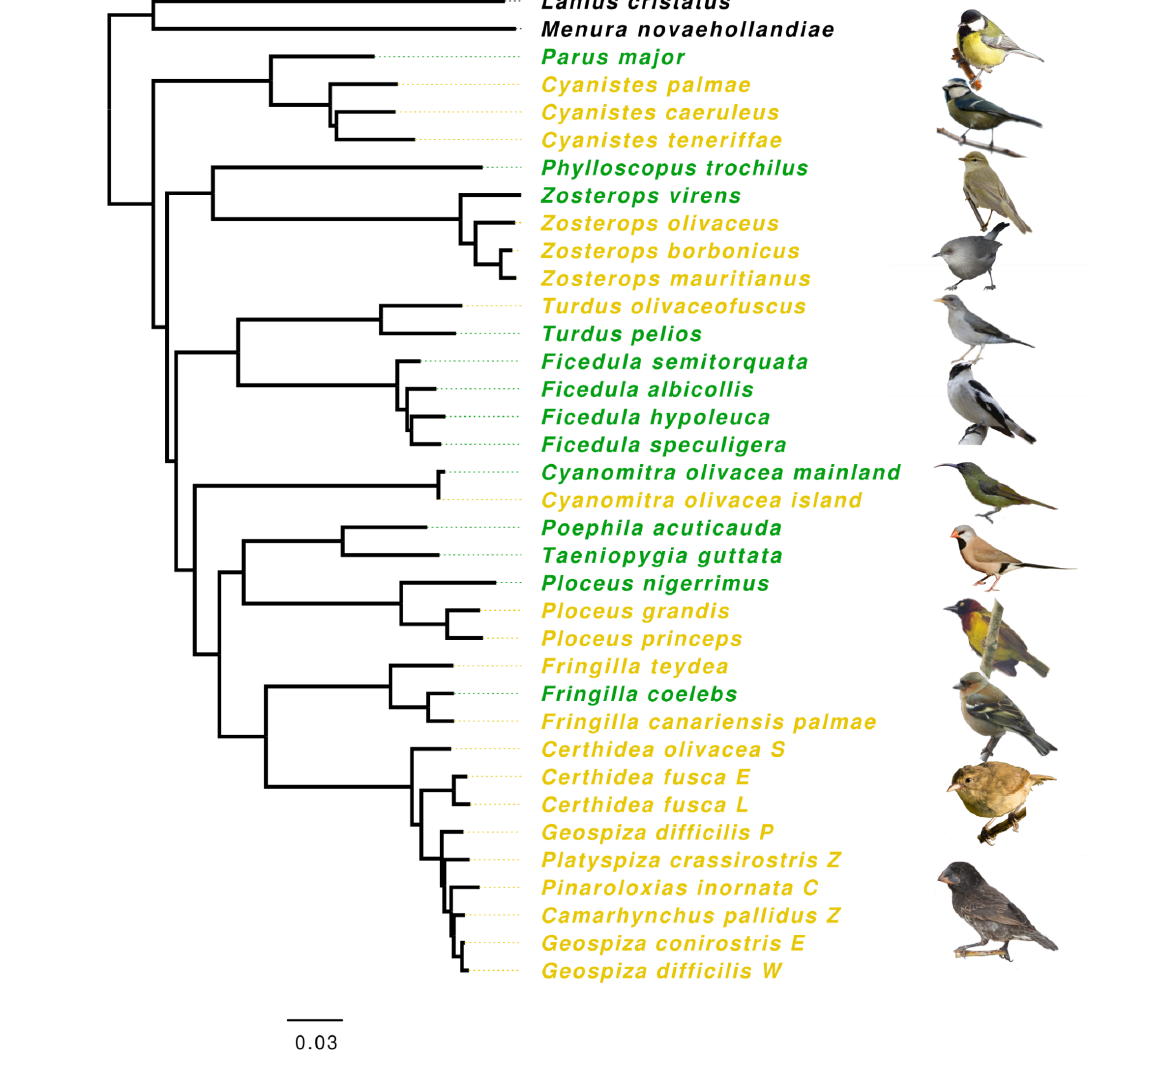
Figure 1: Phylogeny based on mitochondrial genes of species from the dataset reconstructed by maximum likelihood method (IQTREE model GTR+Gamma). Species names in yellow indicate island species, and in green, mainland species. Ultrafast bootstrap values are provided in the supplementary methods. Some relationships are poorly supported. Bird representations are not to scale. Photos from top to bottom : P. major, C. caeruleus, P. trochilus, Z. borbonicus, T. pelios, F. albicollis, C. olivacea,